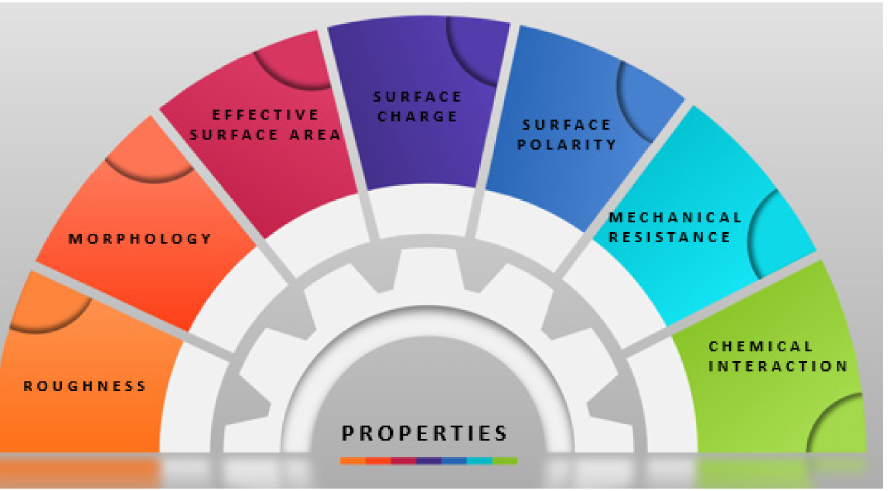
Figure 7. The connection between the properties of the material applied as a surface coating